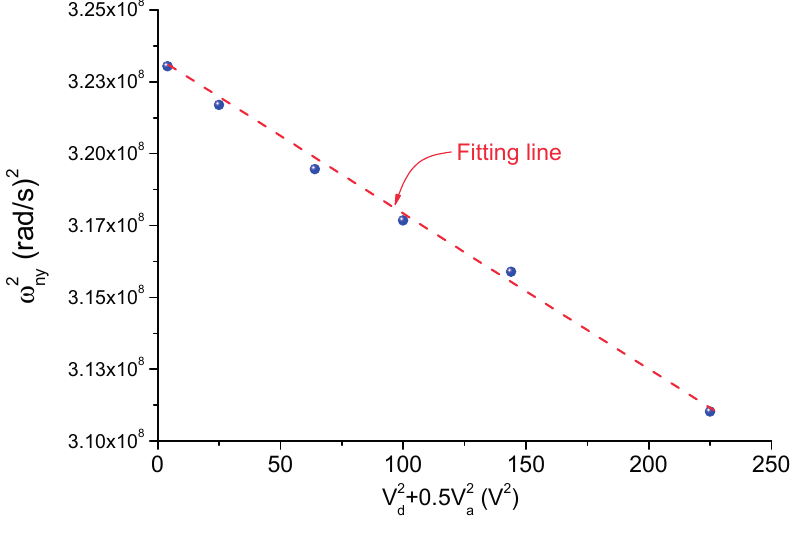
Figure 14. The negative electrostatic stiffness of the sense mode. Table 1. The parameters of the sense mode and the driving frequency from the experiments. Parameters Unit Before modification After